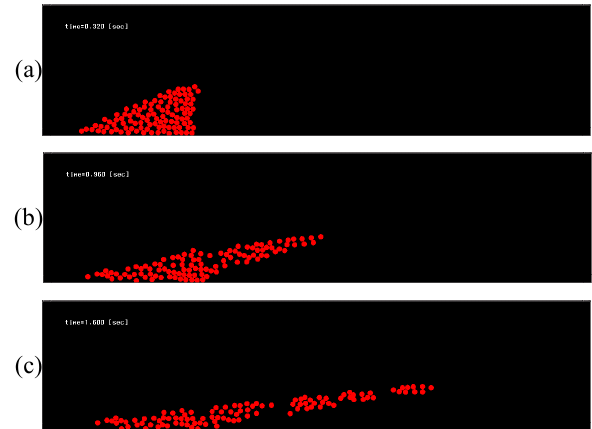
Fig. 4 The destruction process of the primary thrombus obtained from the computation for N bind = 5. (a) t = 0.32 [s]. (b) t = 0.96 [s]. (c) t = 1.60 [s]. The particles separated from the original primary thrombus tend to form aggregations due to the adhesive force caused between the particles.